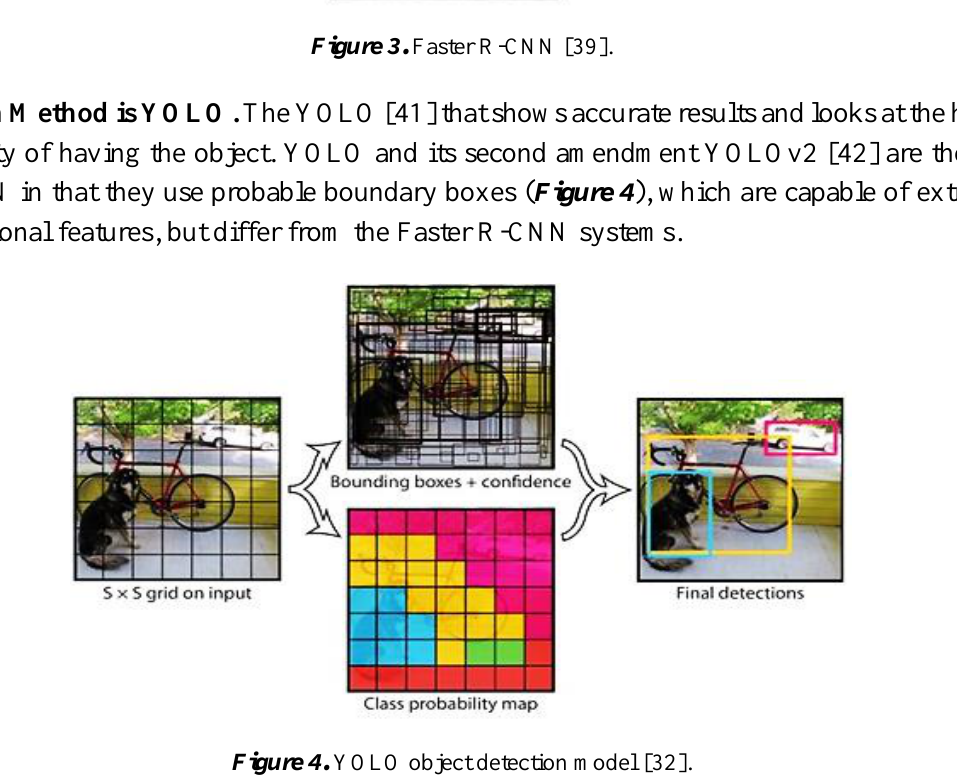
Figure 4. YOLO object detection model